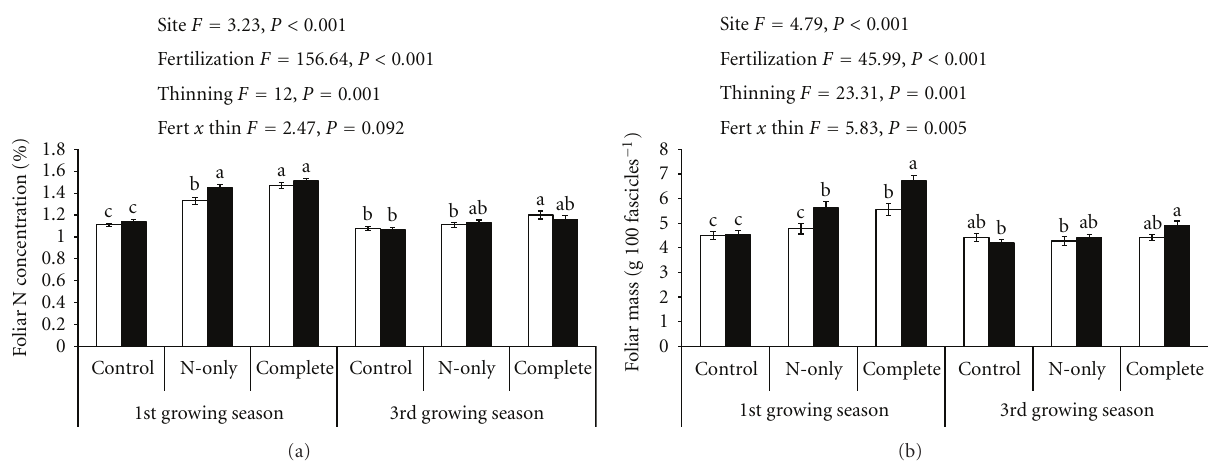
Figure 3: Response of (a) foliar nitrogen concentration and (b) mass of 100 fascicles to thinning and fertilization treatments after 1 and 3 growing seasons. White bars represent unthinned stands and black bars represent thinned stands. Di ff erent letters represent significant di ff erences among treatments for each growing season. ANOVA statistics are given for the 1st growing season data.